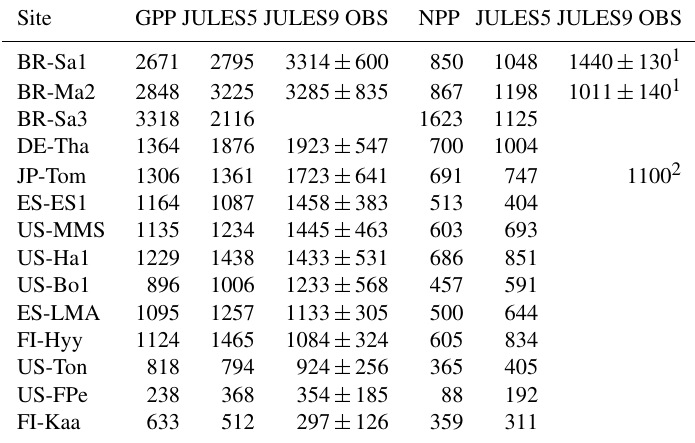
Table 5. Comparison of simulated and observed annual GPP and NPP at FLUXNET sites, listed in order from most to least productive. Units:gCm − 2 year − 1 . Results are color-coded so blue shows when there is an improvement. The GPP and NPP are based on similar data processing between the FLUXNET observations and model. Sources: 1 Malhi (2009); 2 Gower and Richards (1990), assuming 0.5gCg − 1